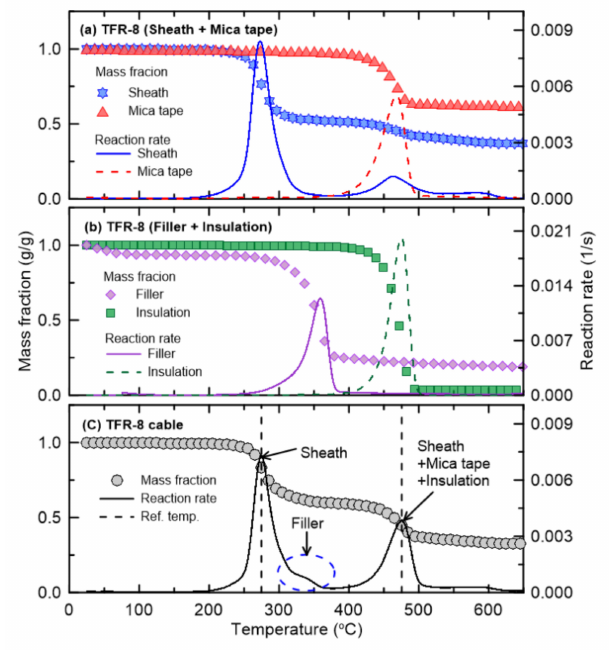
Figure 4. Comparison of mass fraction and reaction rate as a function of temperature for TFR-8 cable.